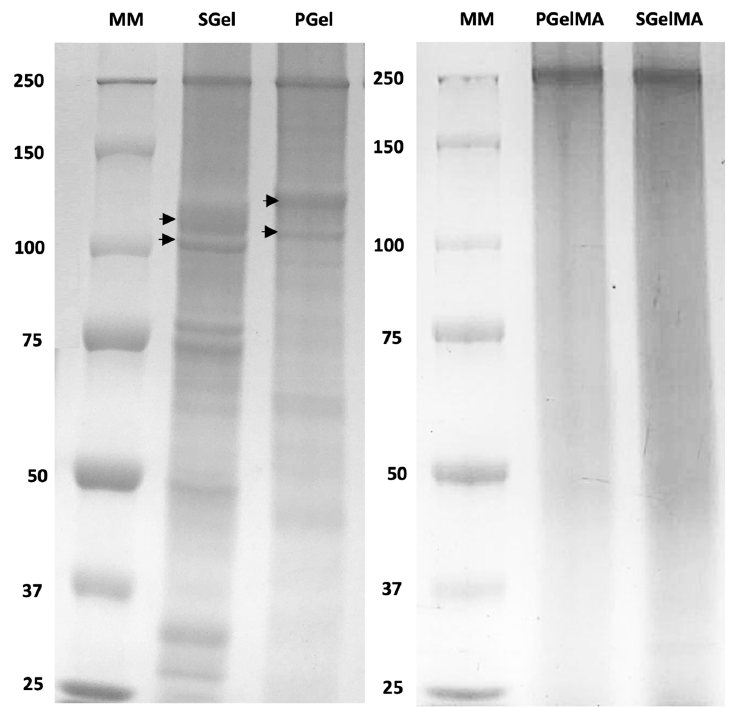
Figure 1. SDS-PAGE of gelatin samples. MM: corresponds to the molecular weight marker in kDa. Arrowheads indicate 𝛼 -chains present in gelatin from salmon (SGel) and porcine origin (PGel). Regarding the methacryloyl gelatins, the results di ff er from the non-functionalized gelatins showing a less de fi ned molecular weight pro fi le. This result was further explored by increasing the acrylamide concentration of the electrophoresis gels, using di ff erent de- naturation conditions and di ff erent bu ff ers to facilitate the migration of the sample in the acrylamide gel, where no de fi ned bands positioned at 125 kDa or lower could be identi fi ed (Figure 1).